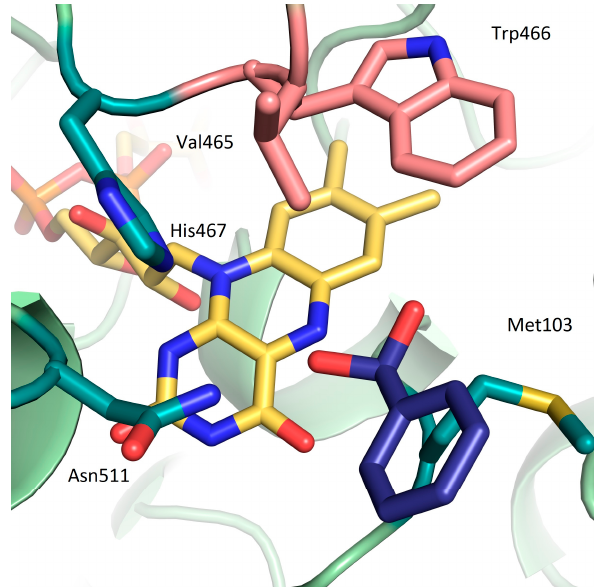
Figure 1. Wild-type HMFO active site (PDB 4UDP): FAD (yellow), residues surrounding flavin-N5 are shown in green (Met103, Asn511, His467), residues selected for site-directed mutagenesis are highlighted in pink (Val465, Trp466), and benzaldehyde hydrate ( gem -diol of 1b ) is shown in blue.